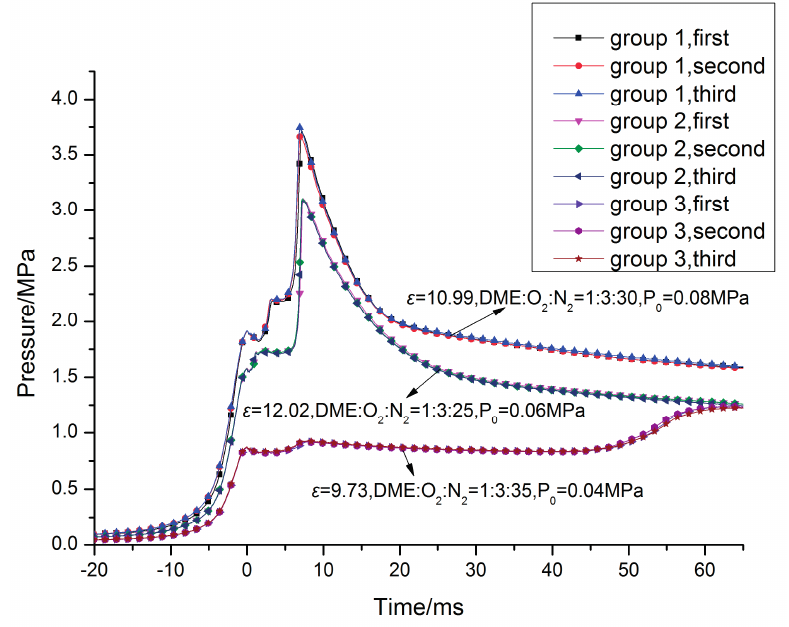
Figure 14. Experimental repeatability of compression and auto-ignition